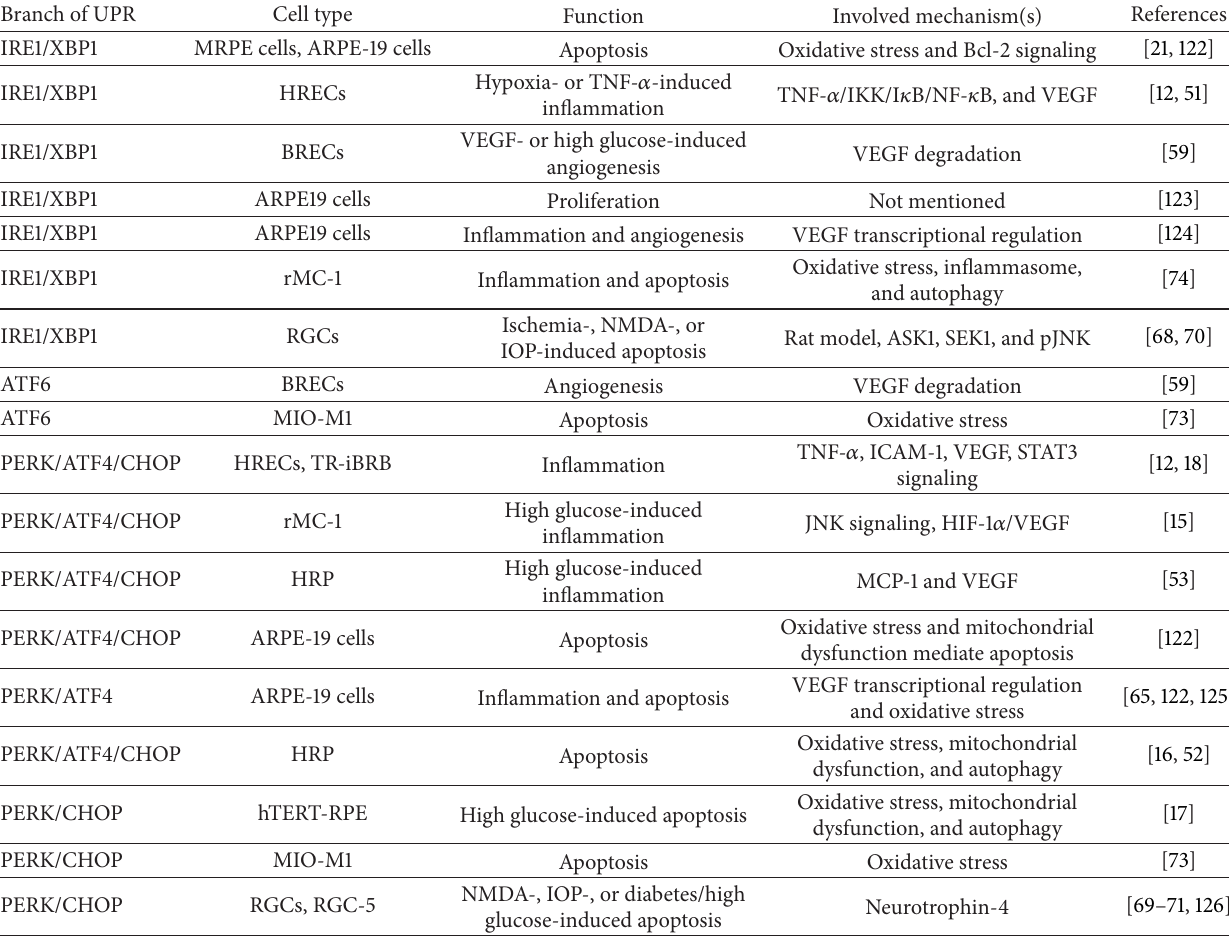
Table 1: Implications of UPR pathways in retinal pathophysiology pertinent to